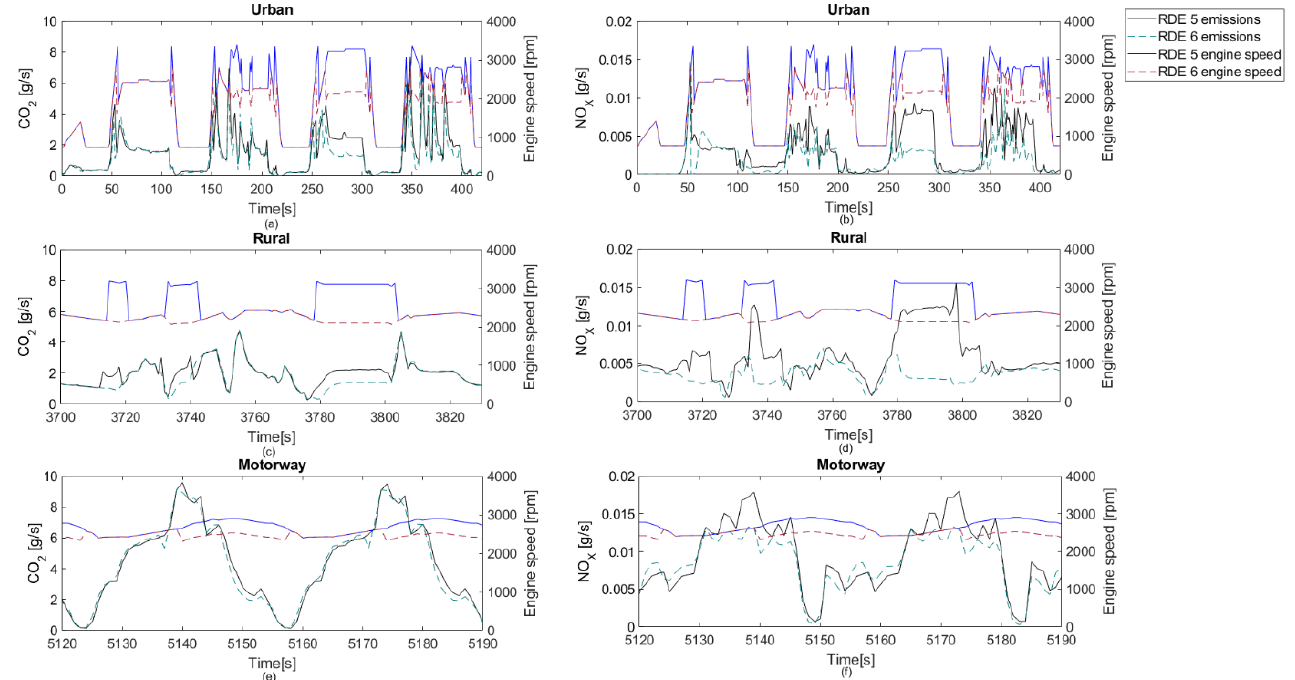
Figure 9. Comparison of Urban ( a ), Rural ( c ) and Motorway (e) CO 2 emissions and Urban ( b ) Rural ( d ), and Motorway ( f ) NO X emissions, and engine speed between RDEs 5 and 6.